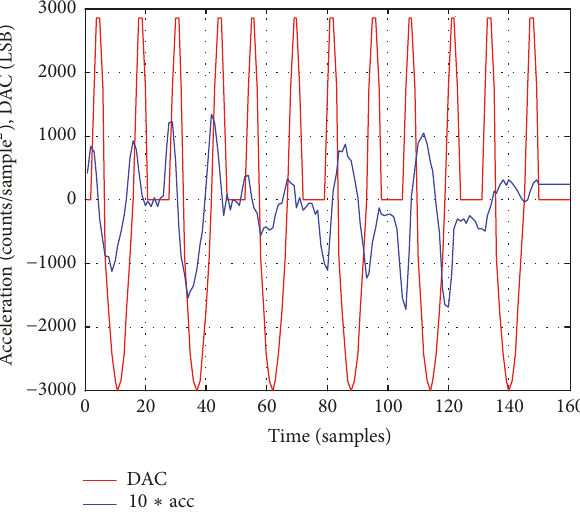
Figure 9: The waveforms of the acceleration and